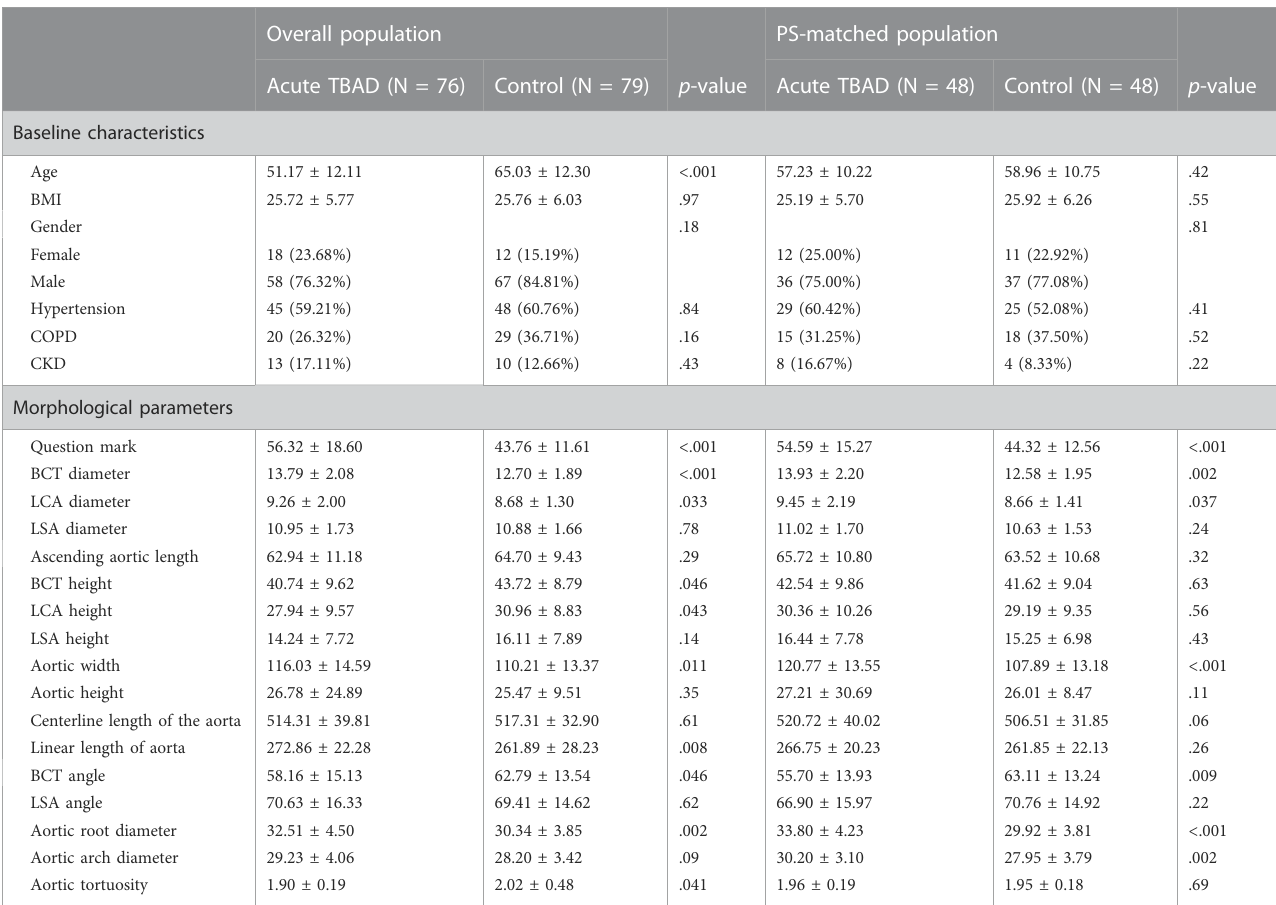
TABLE 1 Baseline characteristics of the included